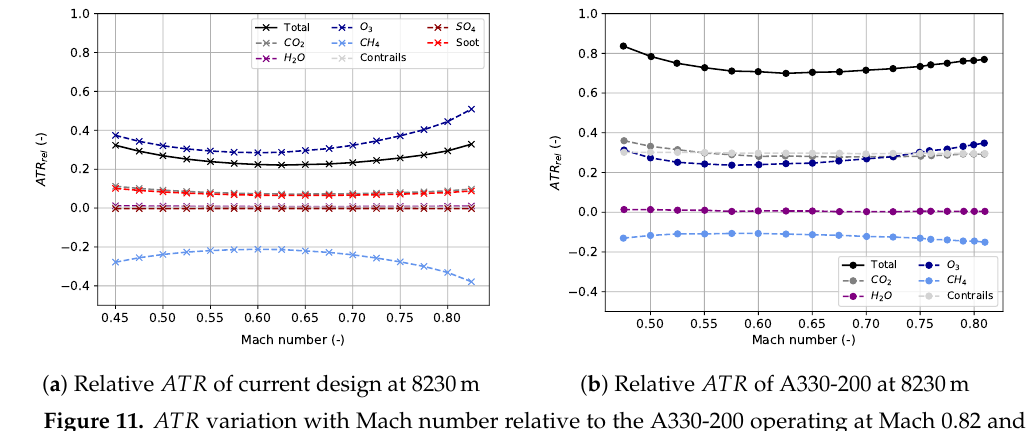
Figure 11. ATR variation with Mach number relative to the A330-200 operating at Mach 0.82 and 10,973 m (A330-200 data from